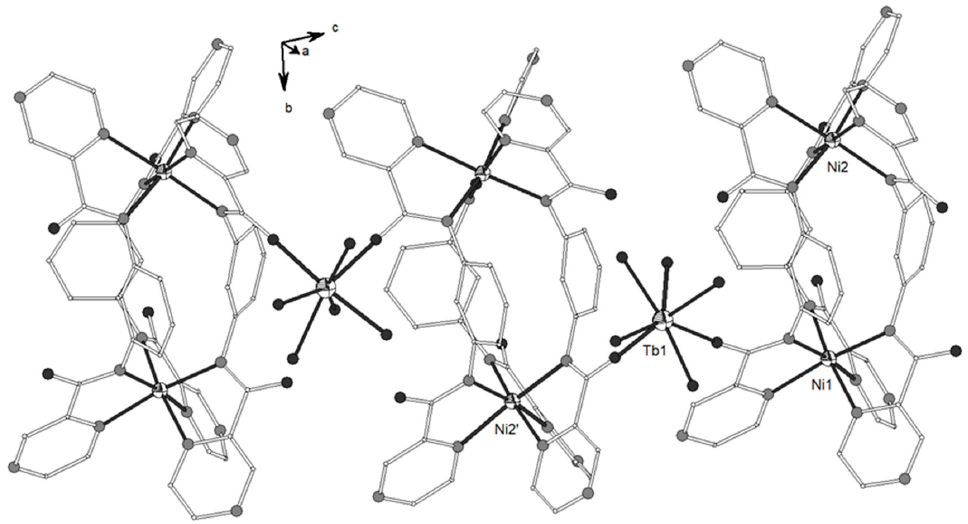
Figure 21. Part of the 1D cationic structure of 166 . Primed atom is generated by symmetry (‘) − 0.5 + x , 0.5 − y , − 0.5 + z . Color code as in Figure 19